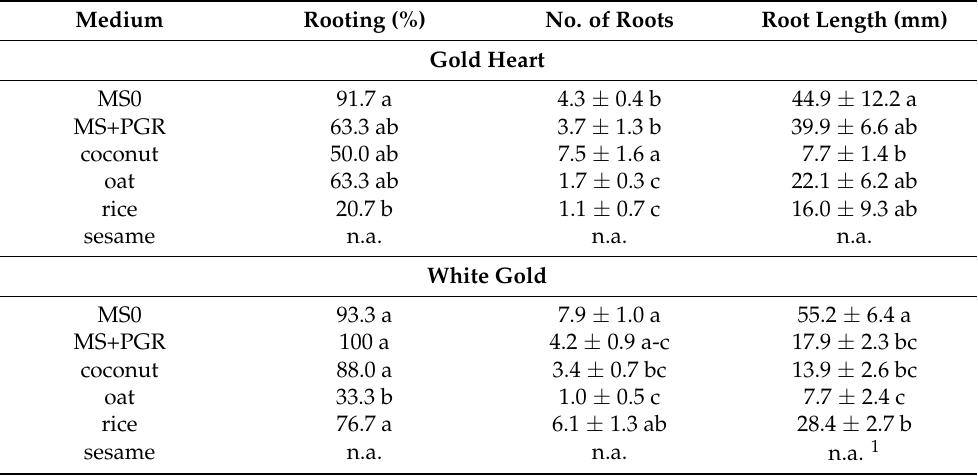
Table 2. Influence of medium composition on the rooting rate (%), number, and length (mm) of roots produced by a single shoot in L. spectabilis after 10 weeks of culture.